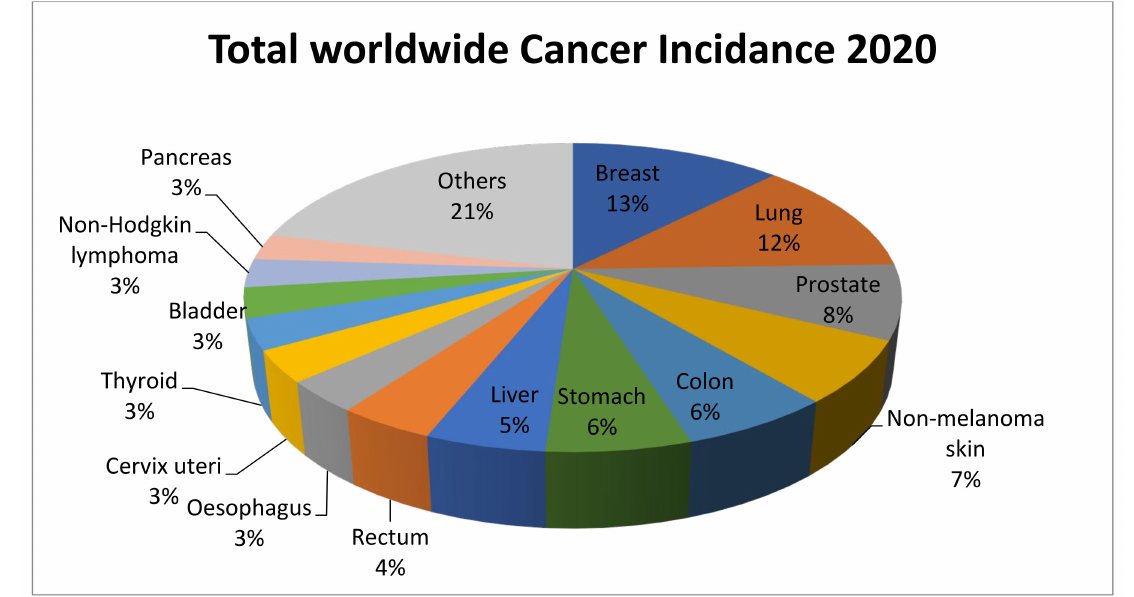
Figure 1. Worldwide distribution of the estimated new cases of cancer in 2020. The data were extracted from earlier published data